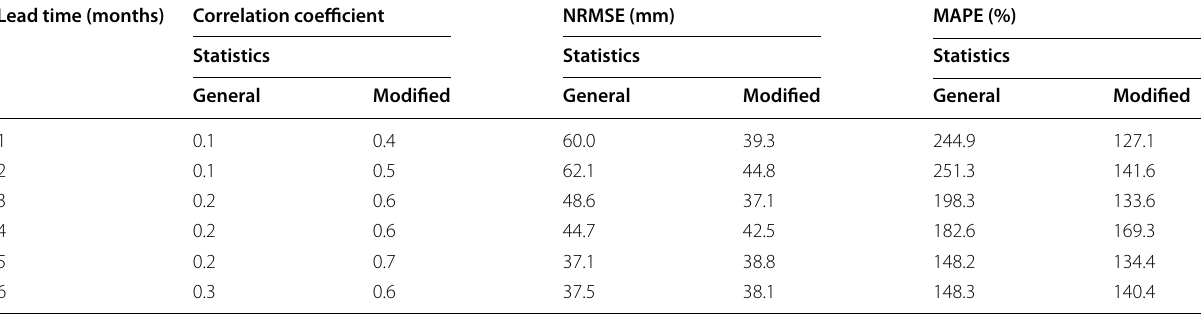
Table 13 Comparison of the predicted results of the monthly precipitation obtained using the general and modified model according to the lead time Lead time